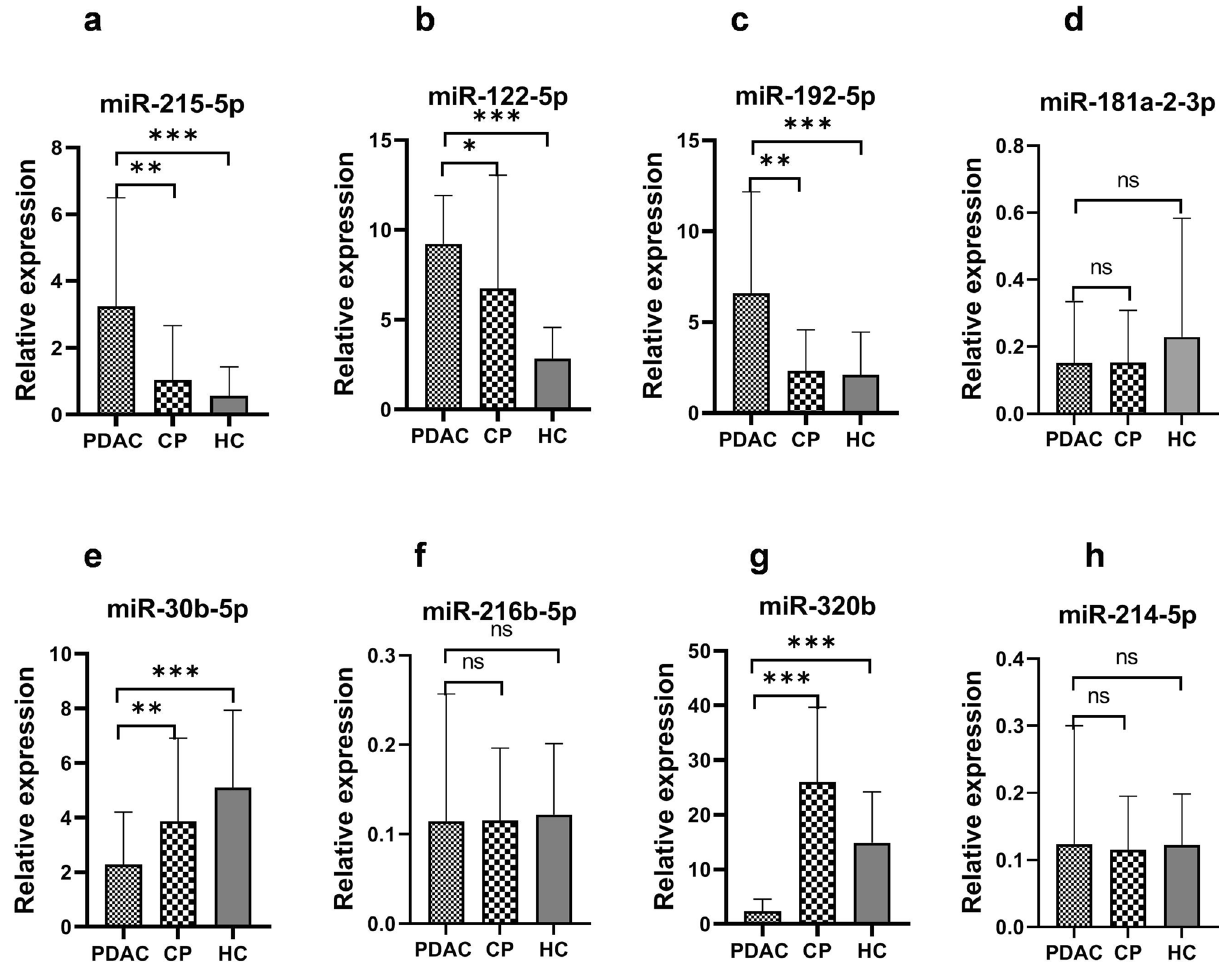
Figure 2. Relative levels of up-regulated miRNAs in serum of PDAC compared with that in CP and HC ( a – d ) and down-regulated miRNAs in serum of PDAC compared with that in CP and HC ( e – h ). *p < 0.01, **p < 0.001, ***p < 0.0001. Relative expression in FFPE tissue mean +/− SD p-value comparing PDAC Stage I + II PDAC Stage III + IV miRNA CP (n = 9) (n = 4) (n =